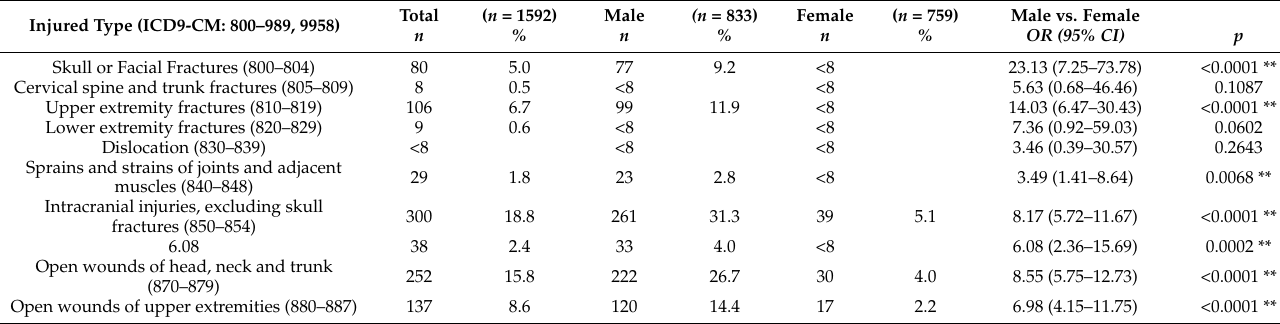
Table A1. Relative Risk of Injury Patterns (By